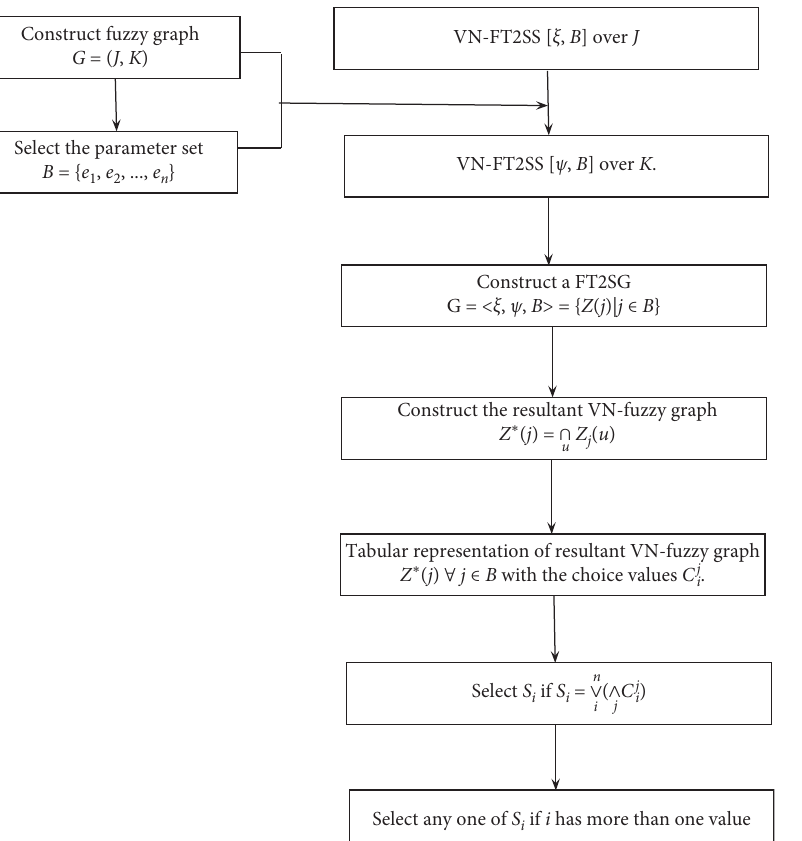
Figure 23: Flow chart for suitable selection of